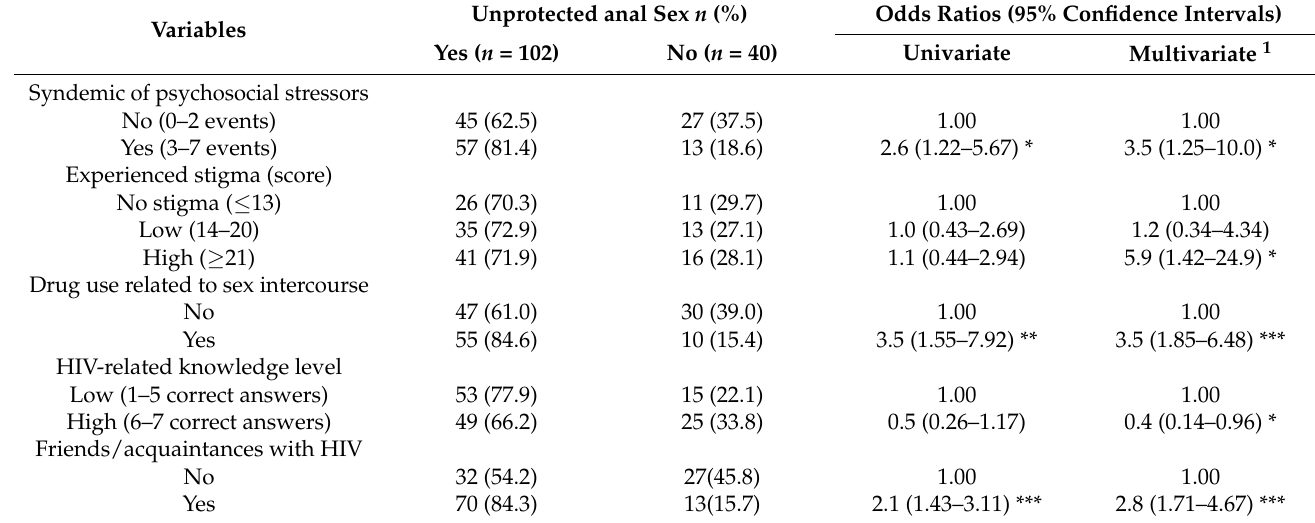
Table 5. Crude and adjusted odds ratios from binary logistic regression for variables associated with unprotected anal sex practices during the last six months in sureveyed men who have sex with men in Manzanillo, Mexico,